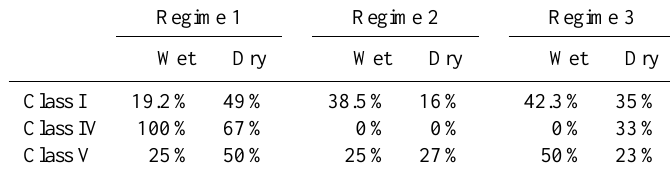
Table 6. Distribution of Cava’s classes associated with the turbulence regimes for the ATTO site nocturnal boundary layer.